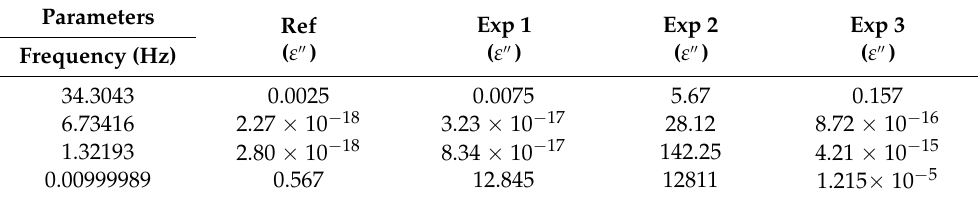
Table 8. Dielectric loss of virgin and aged sample at lower frequencies.